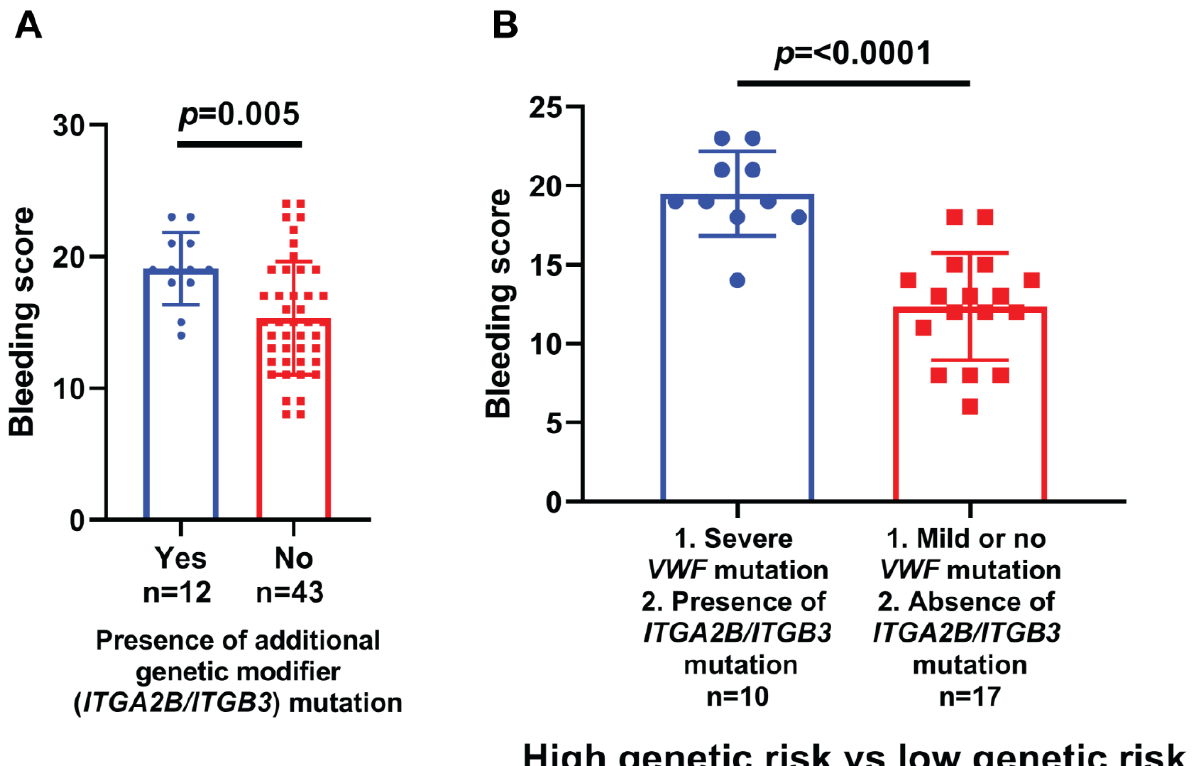
Figure 3. Bleeding score in Pakistani vWD patients stratified by ( A ) presence of additional genetic modifier (ITGA2B/ITGB3) mutation in addition to the causative VWF mutation, and ( B ) high genetic risk vs. low genetic risk.